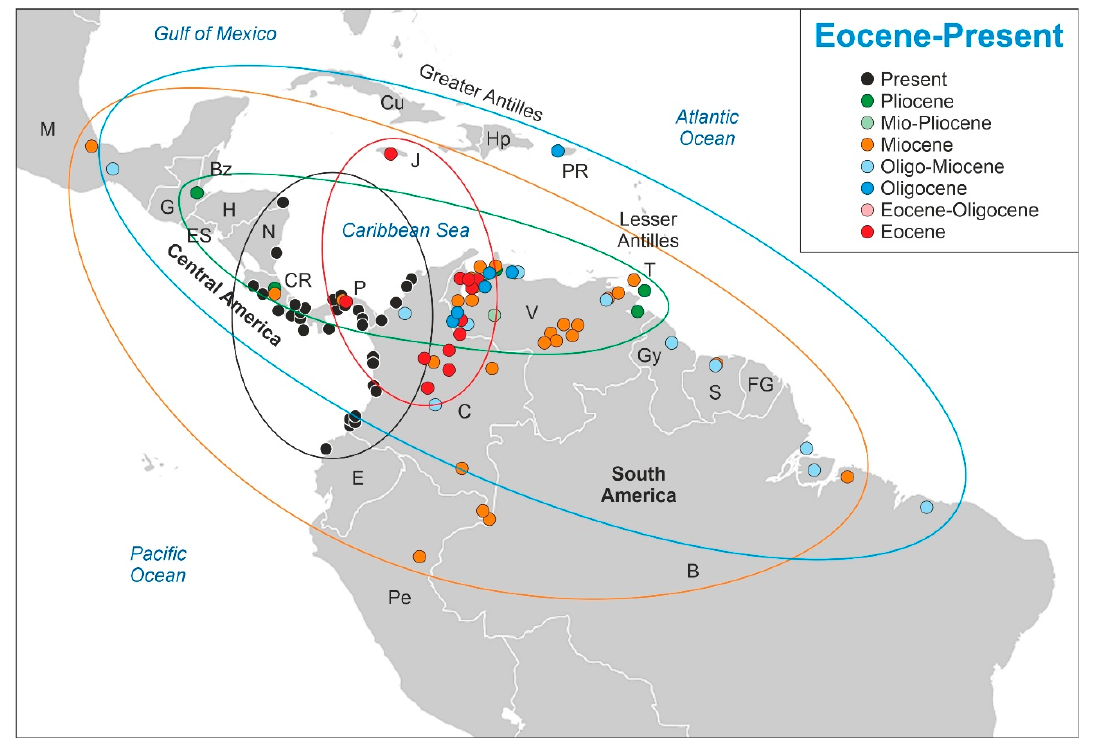
Figure 3. Graphical display of the results from Table S1 (Supplementary Material). Present Pelliciera localities were taken from Figure 2. Countries: B, Brazil; Bz, Belize; C, Colombia; CR, Costa Rica; Cu, Cuba; E, Ecuador; ES, El Salvador; FG, French Guiana; G, Guatemala; Gy, Guyana; H, Honduras; Hp, Hispaniola (Haiti and Santo Domingo); J, Jamacia; M, Mexico; N, Nicaragua; P, Panama; Pe, Peru; PR, Puerto Rico; S, Surinam; T, Trinidad and Tobago; V, Venezuela.